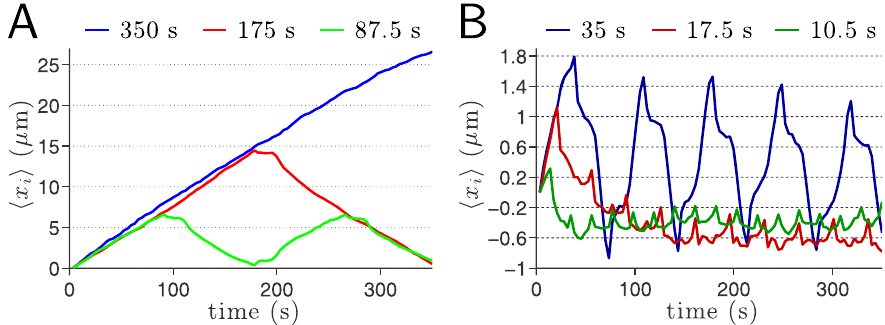
Figure 6. Cell Kinematics: Average displacement along the signal direction for different flow reversal frequencies. Note the difference in scales on the y -axis for both graphs (Fig. S3). (A) For frequencies smaller than 0.01 Hz, on average the cells clearly undergo a uniform translational migration. When the flow direction is reversed, almost immediately the cells stop moving and it takes approximately 20 s before a motion in the opposite direction is measured. (B) For the frequencies f ~ 1 = 35 Hz and f ~ 1 = 17 : 5 Hz, the cells are still able to follow the faster reversals of signal directions but no longer in a uniform way (i.e. at constant speed). For the even higher frequency f ~ 1 = 10 : 5 Hz, some changes in the cells’ migration direction are discernible but the displacements with respect to the x ~ 0 baseline are extremely small: cells are effectively trapped.